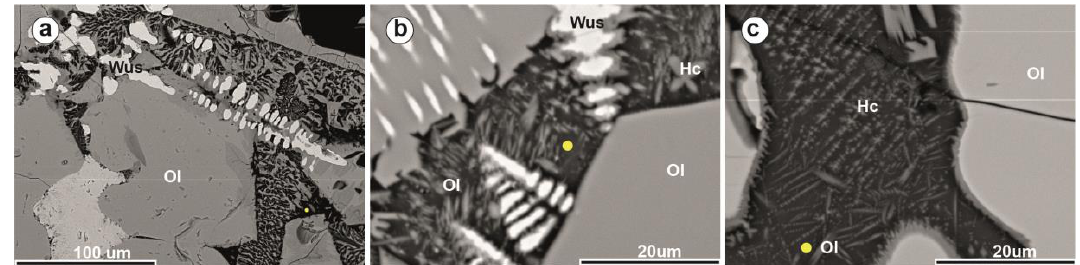
Figure 6. SEM-BSE images showing microcrystals in the vitreous matrix ( a ) Representative image of glass in Medieval Group 1. ( b ) Representative image of glass in Roman Group 4. ( c ) Representative image of glass in Medieval Group 3. Yellow circles correspond to 1 µm representative of minimum EDS analytical spot. Abbreviations after [36]: Ol: Olivine, Wus: Wuestite, Hc: Hercynite.